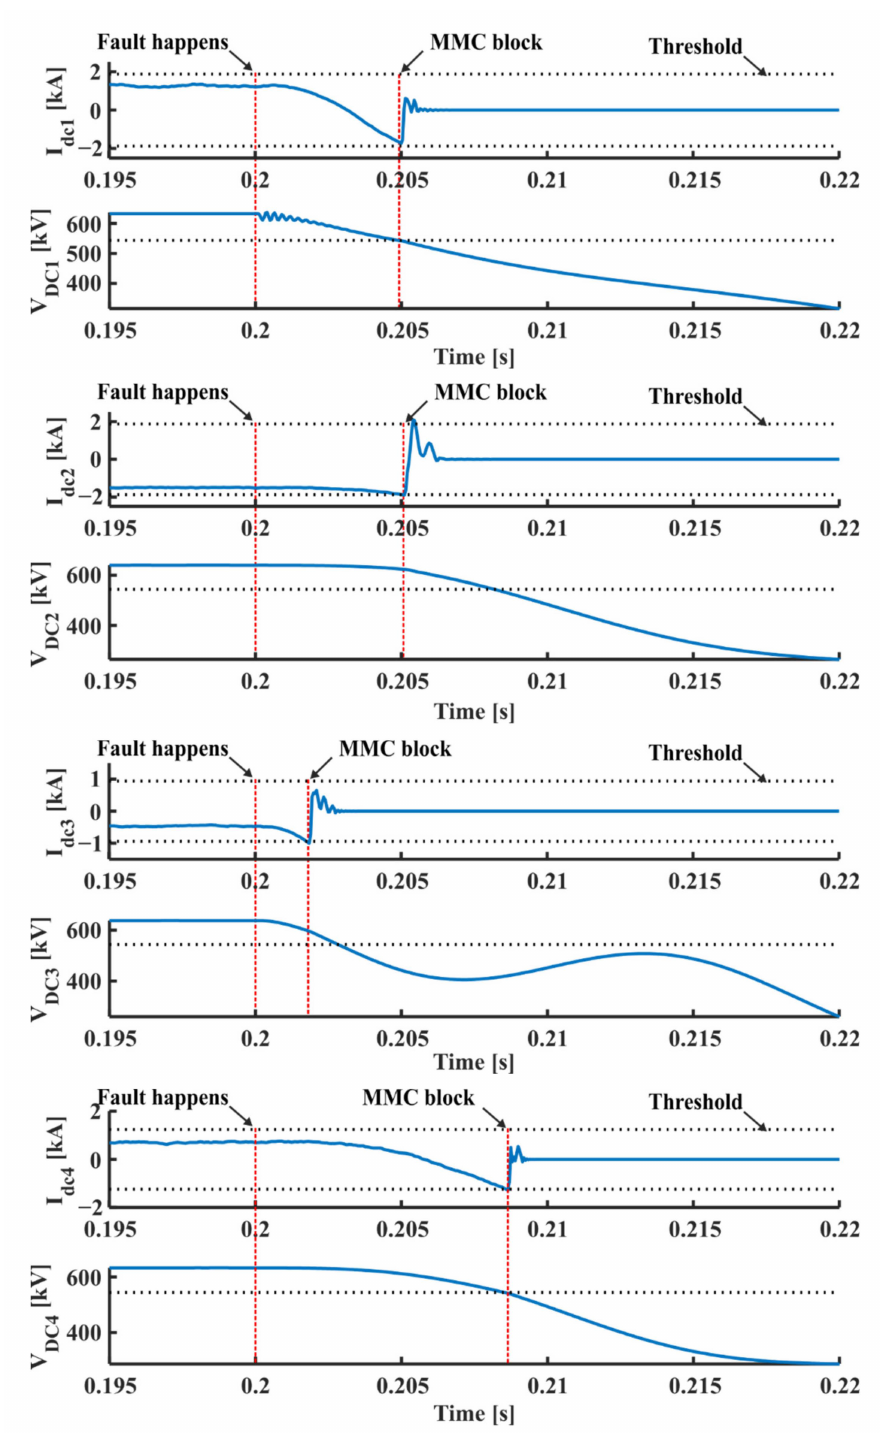
Figure 12. DC currents and voltages of MMCs with P2P DC fault at location